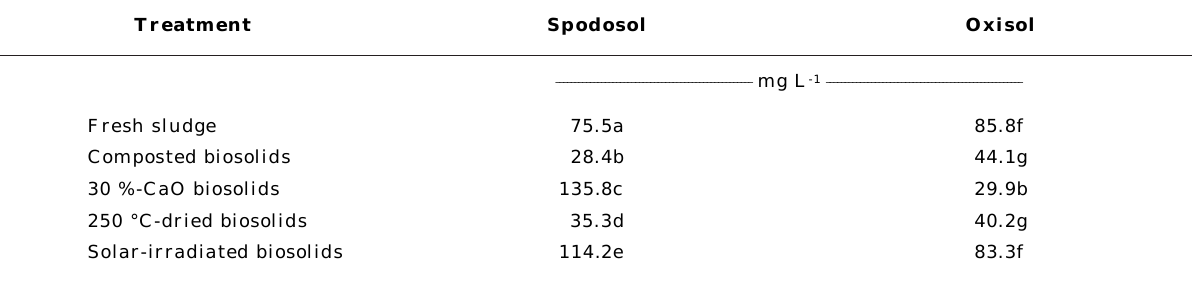
Table 5. Leachate’s maximum NO 3- -N concentrations expected to leave the 20 cm amended-topsoils